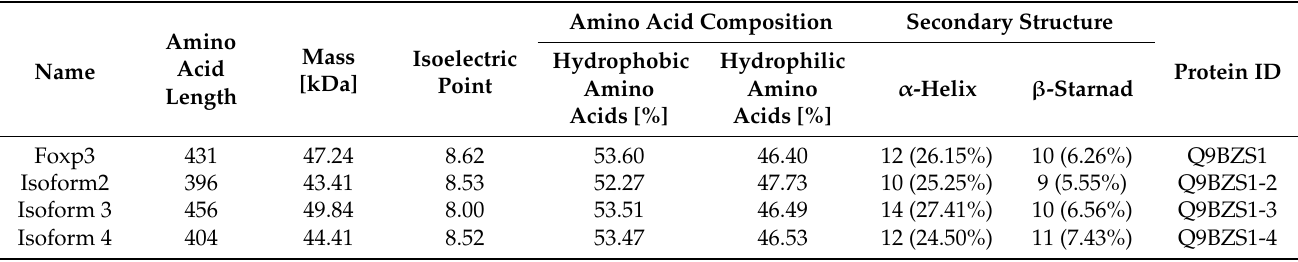
Table 1. Characteristics of the basic properties of the Foxp3 protein and its